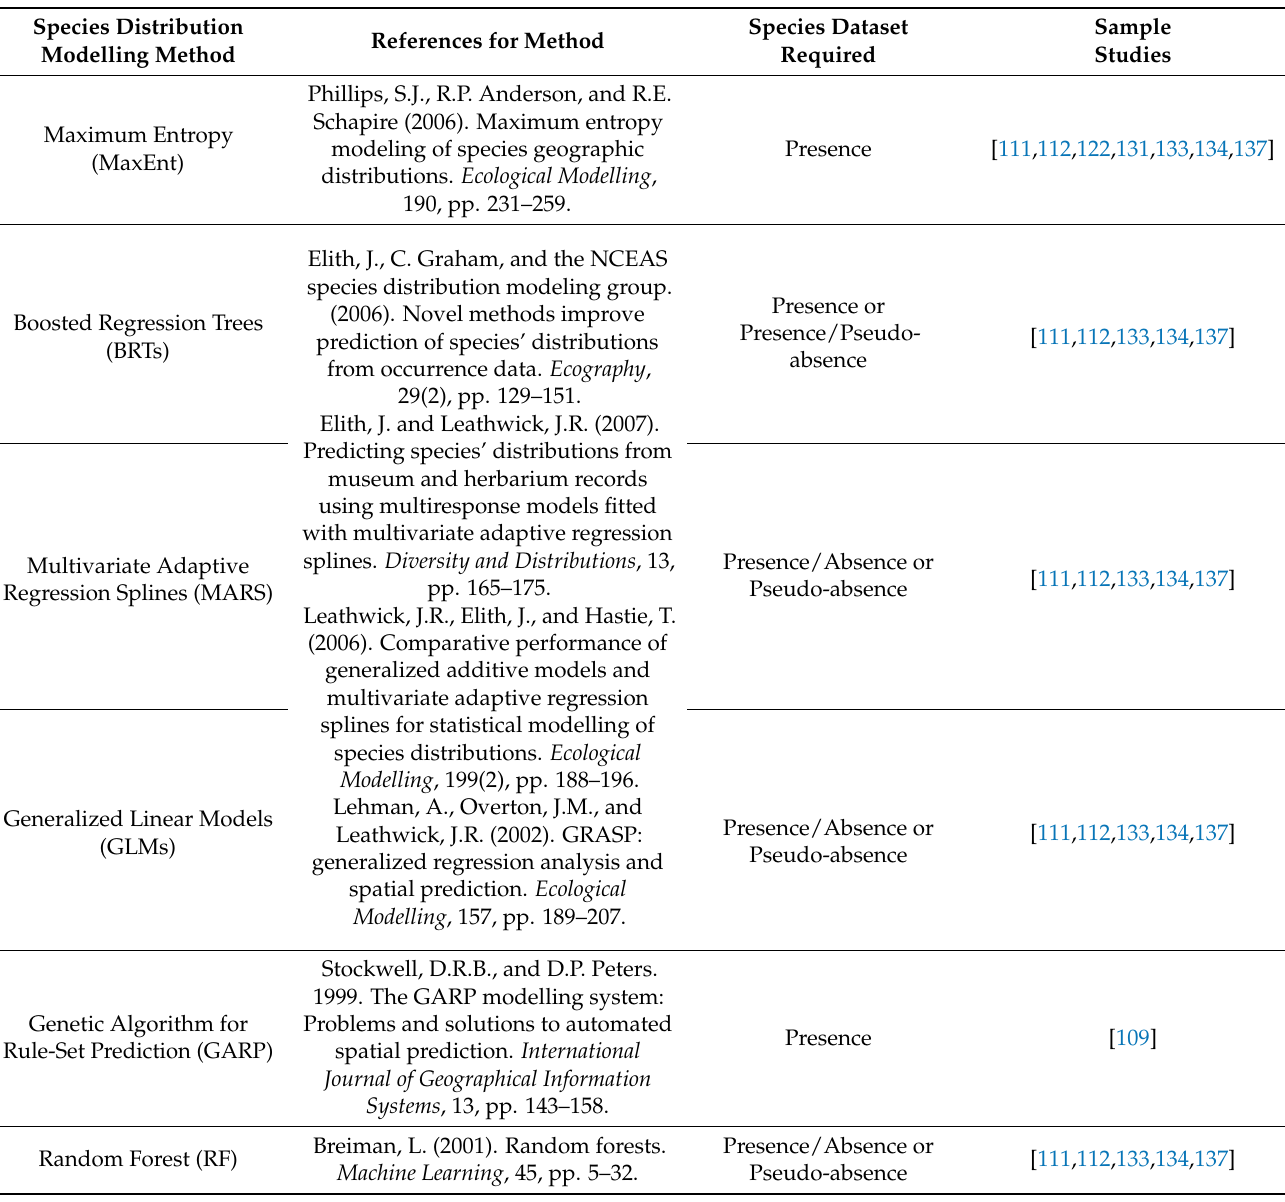
Table 2. Species distribution modelling methods used to map the geographic distributions of